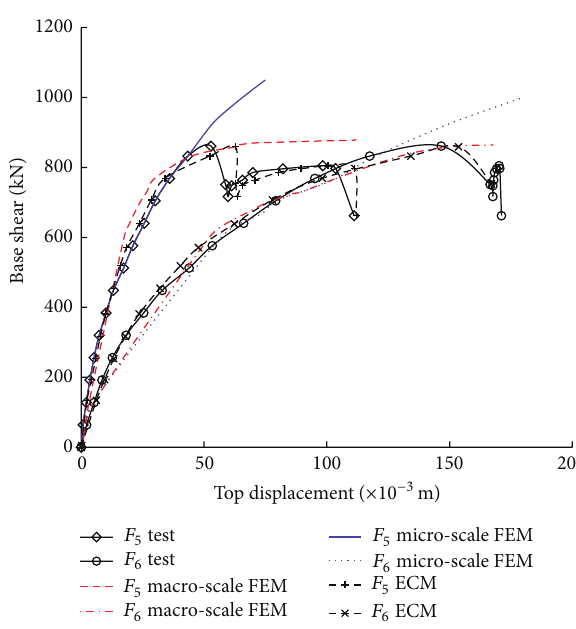
Figure 8: The primarily calculated bearing capacity results com- pared with the test